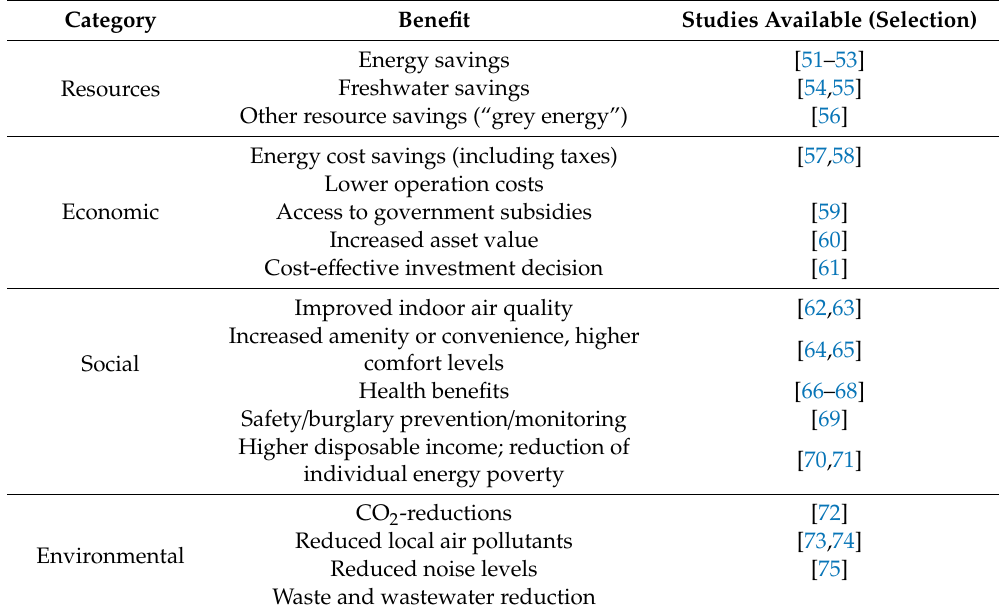
Table 2. Homeowner benefits of increased energy e ffi